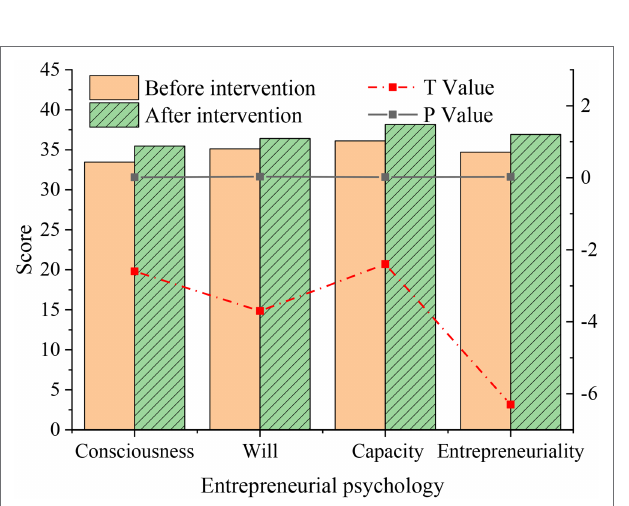
FIGURE 9 | T -test results of paired samples in each dimension of pre-test and post-test in the control